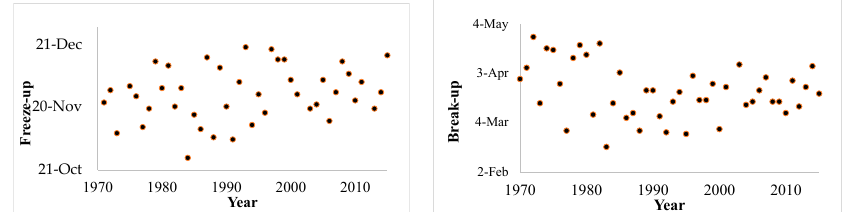
Figure 3. Ice freeze-up ( left ) and break-up ( right ) conditions at the Elbow River gauge between 1970 and 2010.